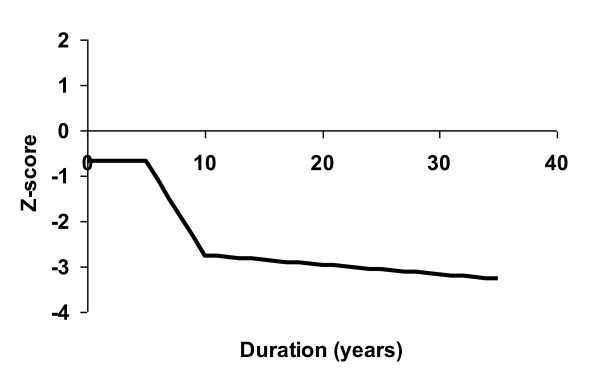
DXR-BMD in relation to disease duration. The mean Z-score (SD) of the patients was estimated as piece-wise linear and continuous function of the disease duration. The corresponding function for the general population coincides with the x-axes. (Z-score = -0.6796 + 0.0028 min(duration, 5) - 0.4177 max(min(duration-5, 10-5), 0) -0.0209 max(duration-10, 0) (multiple correlation coefficient 0.60)).